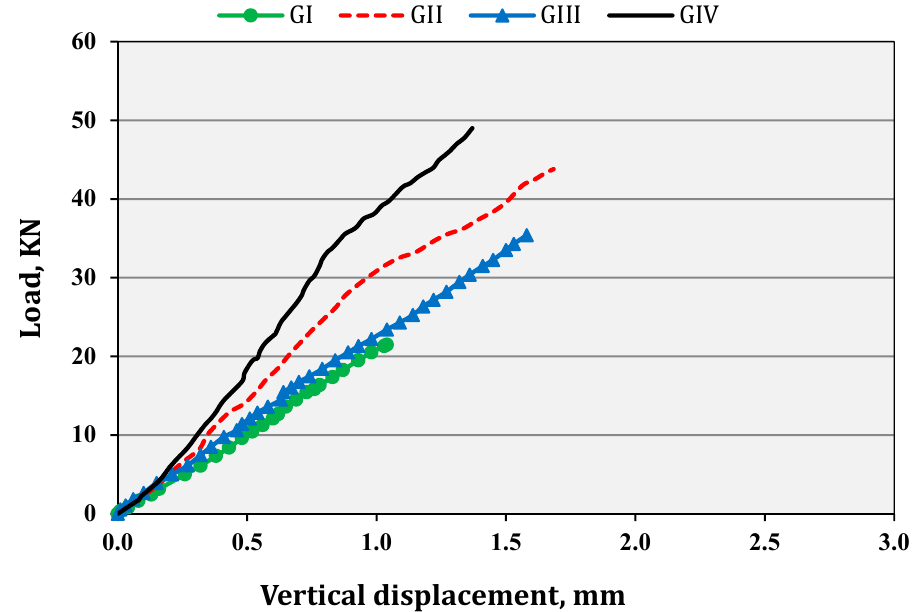
Figure 10. Load vs. vertical displacement for the average of beam-groups at quarter-span.